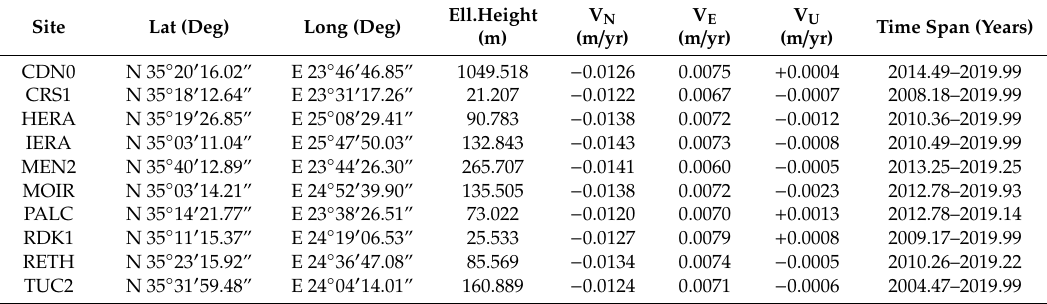
Table A1. The regional Crete GNSS site coordinates and velocities (ITRF 2014) at epoch